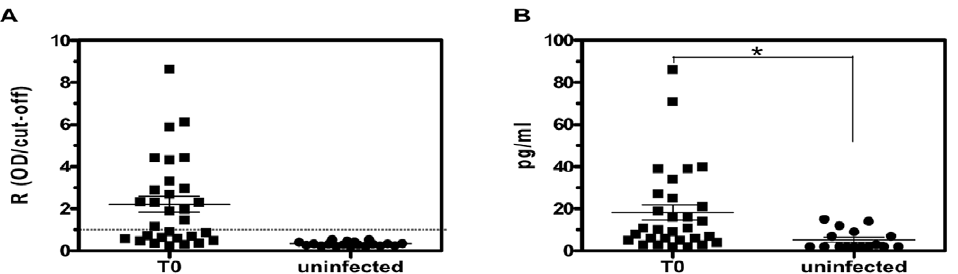
Figure 1. Anti-M2R AAb and IFN- c profiles in pediatric chagasic patients at T0 and uninfected controls. (A) Distribution of anti-M2R AAb in sera. The group mean and the standard error of the mean are depicted. Dotted line shows cut-off level of the assay. (B) Circulating levels of IFN- c . The group mean and the standard error of the mean are depicted. * p =0.015 compared to uninfected controls.